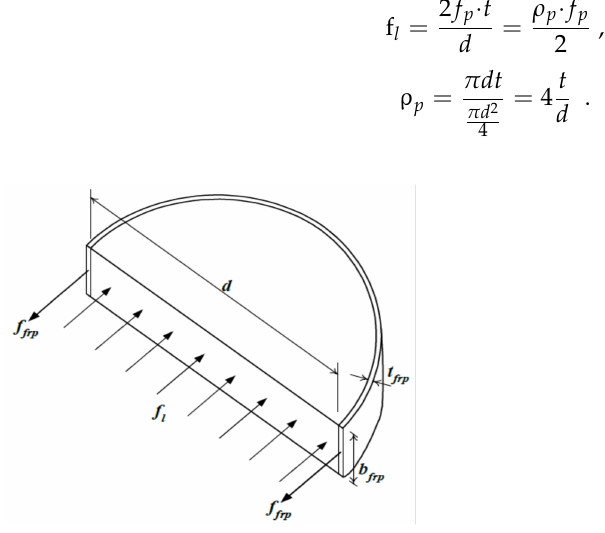
Figure 1. Confinement effect of fiber-reinforced polymer